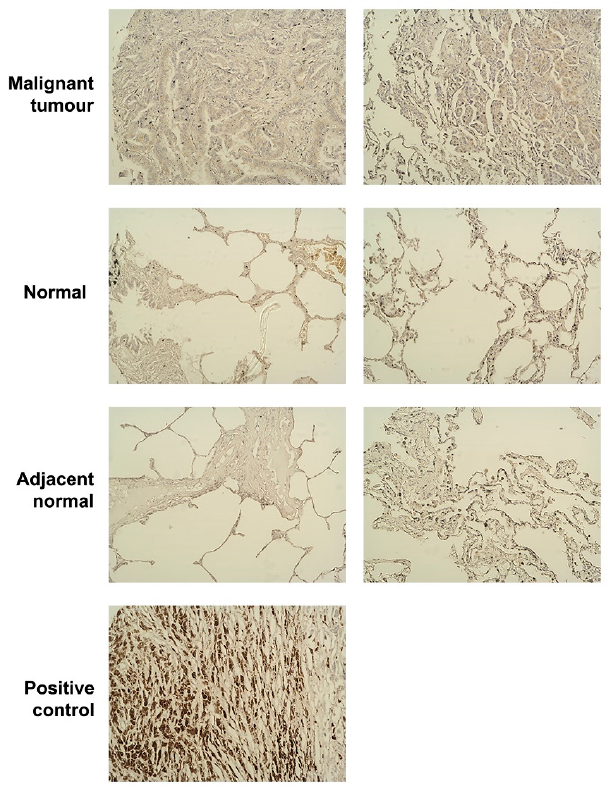
Figure 2. Representative IHC SIPA1 staining images in the TMA. Figure shows malignant tumour tissues, normal pneumonic tissues, cancer adjacent normal pneumonic tissues and the positive con- trol from skin malignant melanoma. All the images were captured at 200× objective